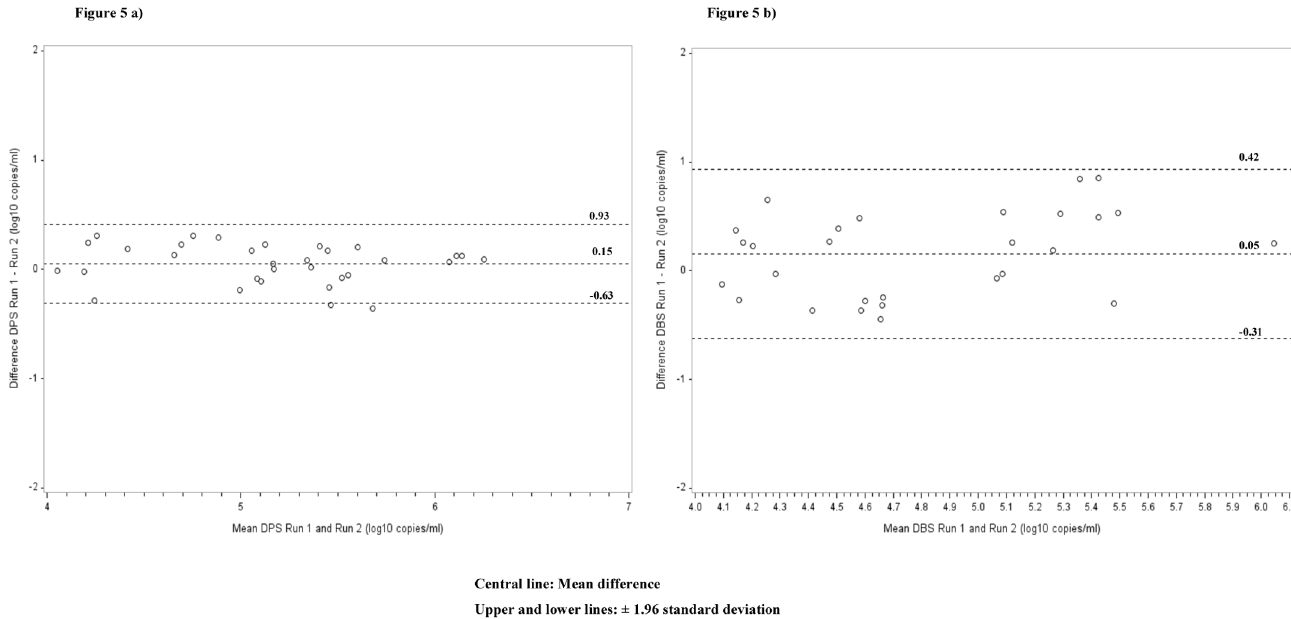
Fig 5. Bland-Altman analyses to evaluate repeatability in HIV-1 viral load quantification in 40 detectable a) DBS b) DPS collected from patients visiting Nyanza patient support centersand tested with Abbott. The difference betweenthe references Run 1 and the comparisons Run 2 were plotted againstthe averageof the reference